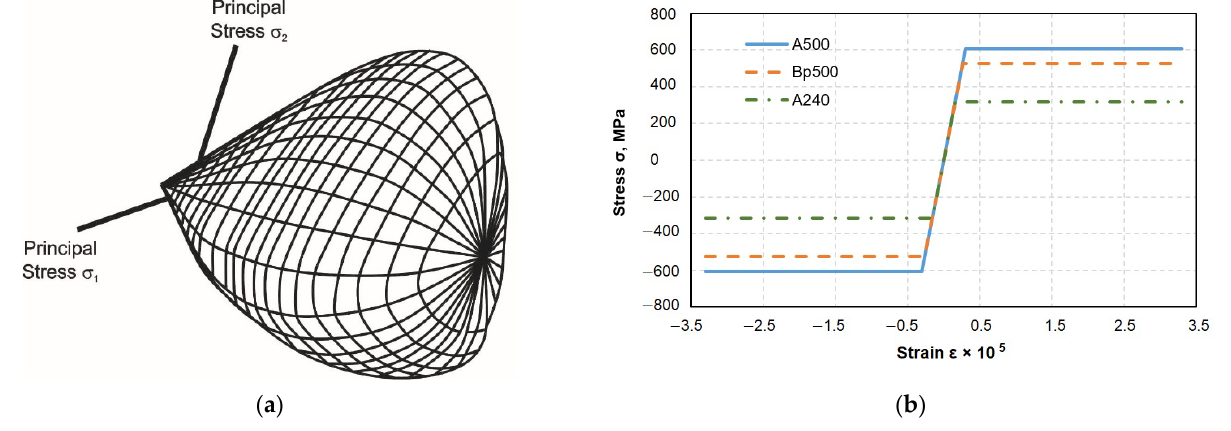
Figure 15. Material models accepted for numerical simulation: CSCM yield surface for concrete ( a ); piecewise linear diagrams for the steel reinforcement ( b ).